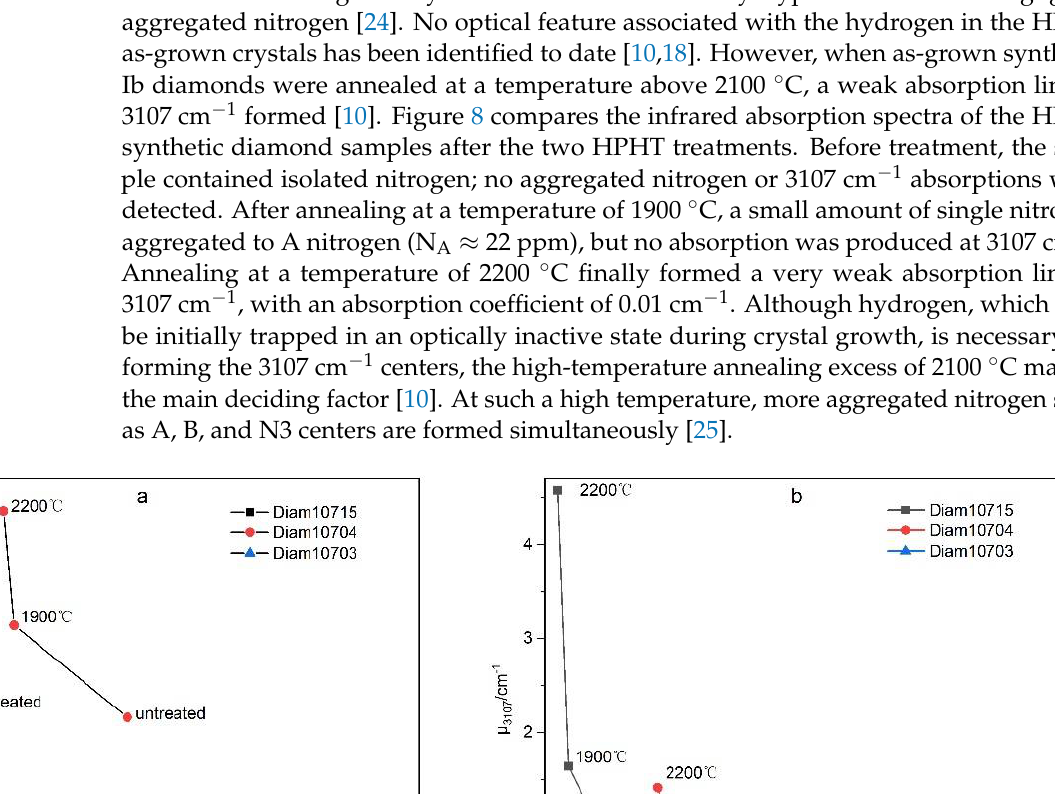
Figure 6. The intensity changes of 3107 and 3143 cm −1 absorption of three natural type Ib diamonds before and after 15 min HPHT-treated process. The 3107 ( a ) and 3143 ( b ) cm −1 absorption peak height increased with the increasing of the annealing temperature.